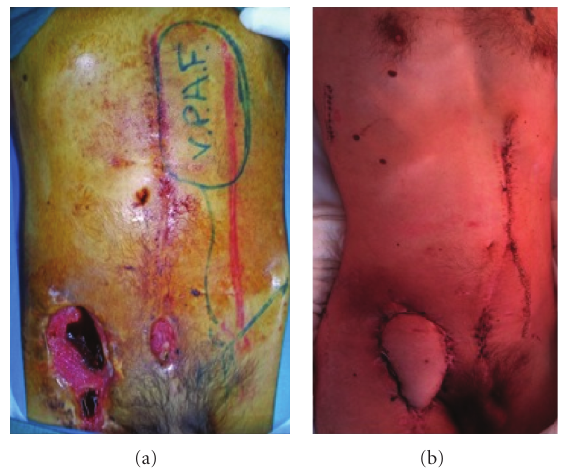
Figure 4: Operative planning (a) and final result (b) after the use of left rectus abdominus muscle as a transposition graft to the right